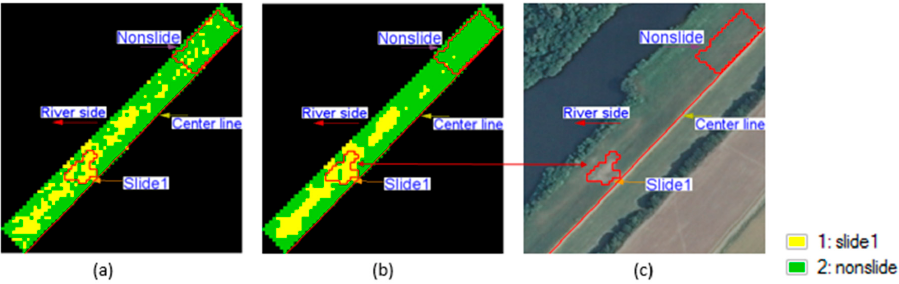
Figure 3. Complex data classification for the segment Sample 1: ( a ) without majority filter; ( b ) with majority filter; ( c ) optical image overlaid with slide and nonslide class shapes.